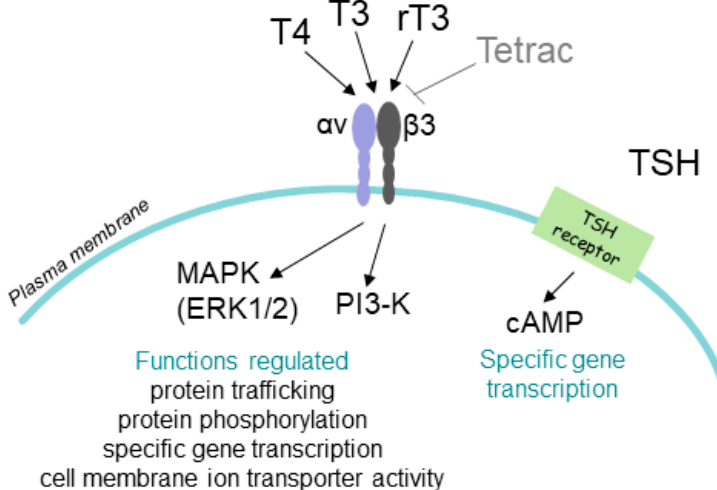
Figure 1. Cancer-relevant actions of thyroid hormones and pituitary thyrotropin (TSH) at thyroid carcinoma cells. Plasma membrane integrin α v β 3 contains a cell surface receptor for thyroid hormones and is overexpressed by cancer cells. T4 is the principal ligand for this receptor and the T4 signal is transduced by mitogen-activated protein kinase (MAPK / ERK1 / 2) or phosphatidylinositol 3-kinase (PI3-K) into cancer-linked gene transcription. A deaminated analogue of T4, tetrac, blocks actions of T4 at the integrin and is under development as an anticancer agent. At physiological concentrations, T3 is not active at the integrin, but reverse T3 (rT3) has cancer cell-stimulating activity at this plasma membrane receptor. T3 is the principal ligand of nuclear thyroid hormone receptors (TRs) in normal cells; TRs are not shown in the figure. Pituitary TSH acts at a specific cAMP-generating receptor on the plasma membrane of thyroid cancer cells. TRs and the TSH receptor are not structurally related to the T4 binding site on α v β 3. 2. T4 Actions at the Integrin α v β 3 in Papillary and Follicular Thyroid Carcinoma Cells